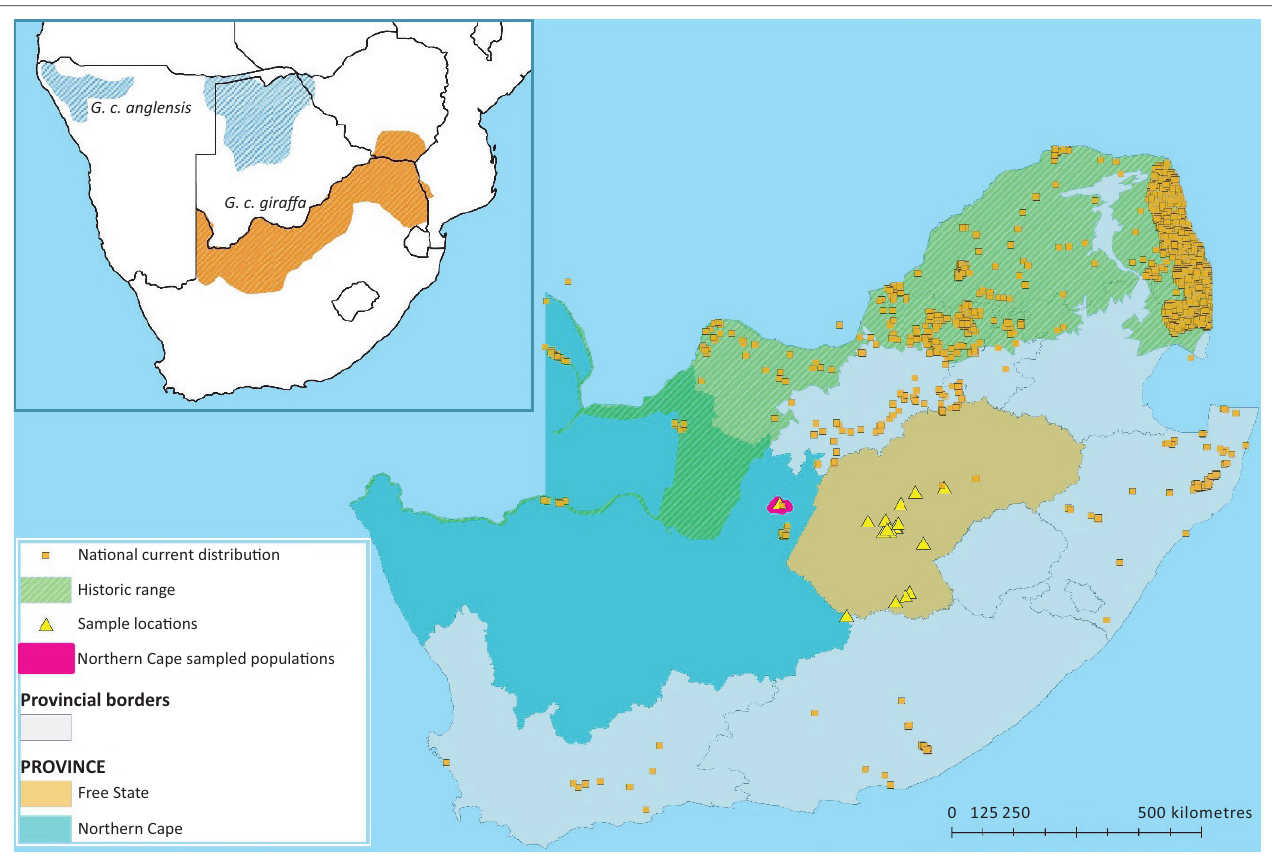
FIGURE 1: The current and historical distribution of giraffe in South Africa, regions sampled and localities referred to in the